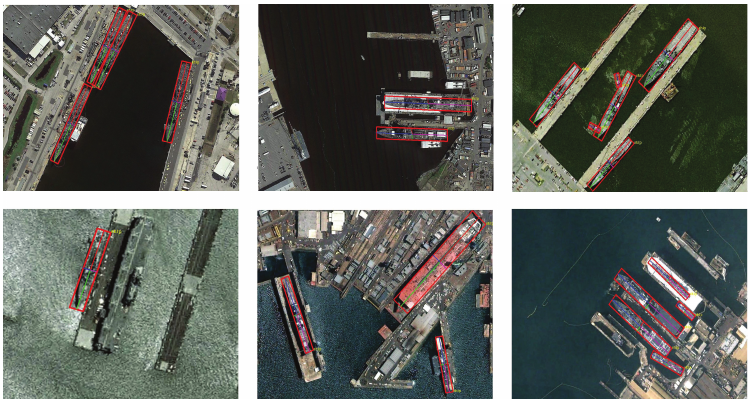
Figure 9. Detection results of the student network on the HRSC2016 dataset.